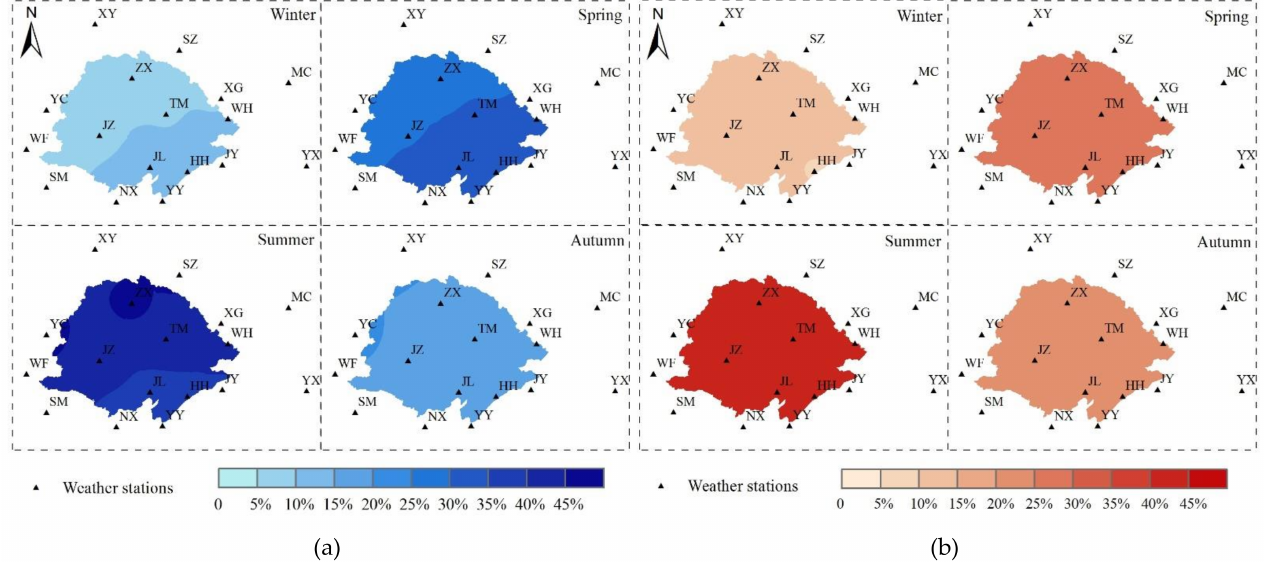
Figure 4. Proportion of mean seasonal precipitation ( a ) and ET 0 ( b ) to the annual in JHP from 1977 to